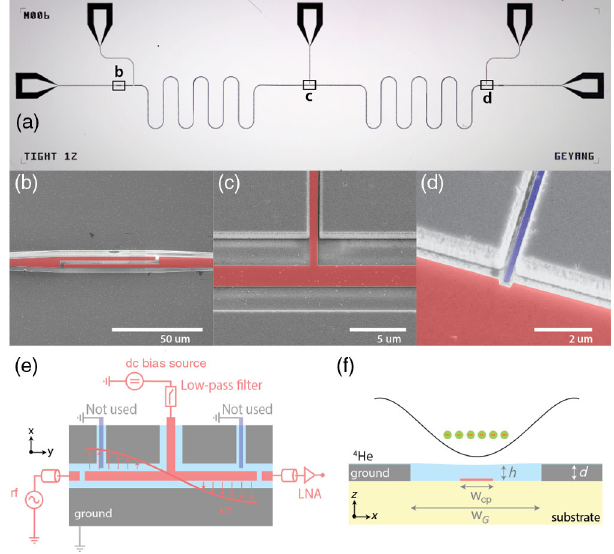
FIG. 1. Device, circuit schematic, and trap geometry. (a) Optical and SEM images of a cavity-electron ensemble trap on a ( 2 × 7 )- mm superconducting chip. The device is positioned 5.5 mm above the bottom of a cylindrical superfluid reservoir of radius r ¼ 3 . 175 mm, mounted in a hermetically sealed copper box at 25 mK in a dilution refrigerator. (b) Interdigitated gap capacitors with gap width 2 μ m at the cavity input. (c) dc bias electrode connected directly to the center pin of the cavity at a node of the standing-wave voltage distribution of the fundamental mode. (d) Sub- μ m-size electron trap near voltage maximum of the fundamental mode with constriction of width 500 nm. (e) Circuit schematic showing the voltage distribution of the fundamental mode (red) and the simplified measurement and control circuit connected to the center pin (pink). The cavity is measured in transmission using a low-noise amplifier (LNA) and the trap potential is tuned through a dc source connected to the center pin (pink) through a low-pass filter. (f) Cross-sectional view of the cavity waveguide gap showing the schematic trap geometry. The ground planes (gray) form a microchannel of height d ¼ 800 nm ¼ 6 μ m filled with superfluid 4 He by capillary and width w G action. A dc voltage on the submerged center pin (pink) of width ¼ 2 μ m and thickness t ¼ 80 nm creates a parabolic trapping w cp potential for electrons above the surface that couple to the rf field in the